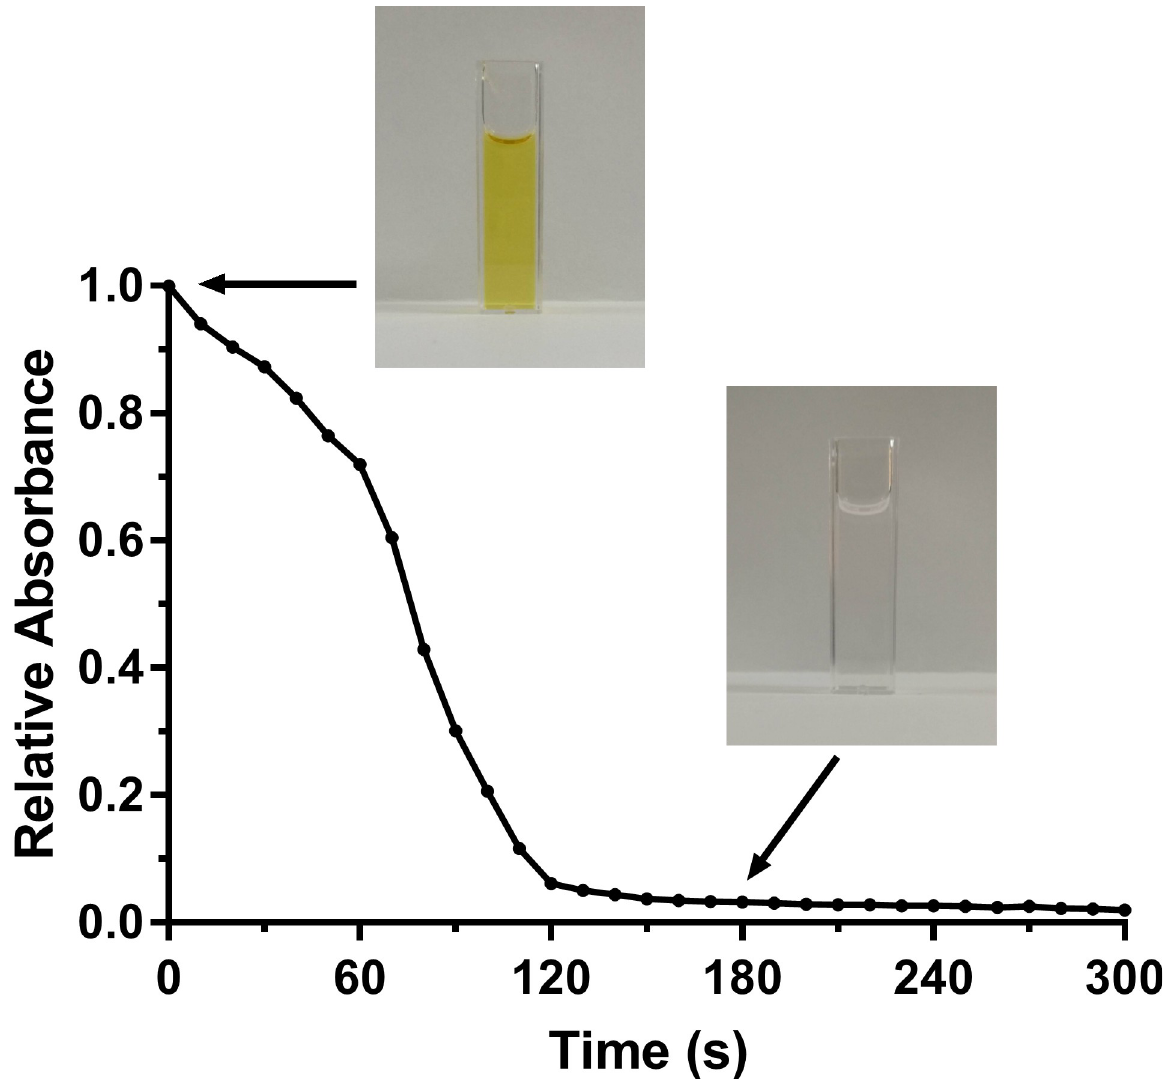
Fig 3. Kinetics of silver core dissolution upon H 2 O 2 addition as measured using the relative absorbance at 404 nm. Photos above the curve show the complete disappearance of the yellowish color of AgNP dispersion upon oxidative dissolution of silver core by H 2 O 2 .